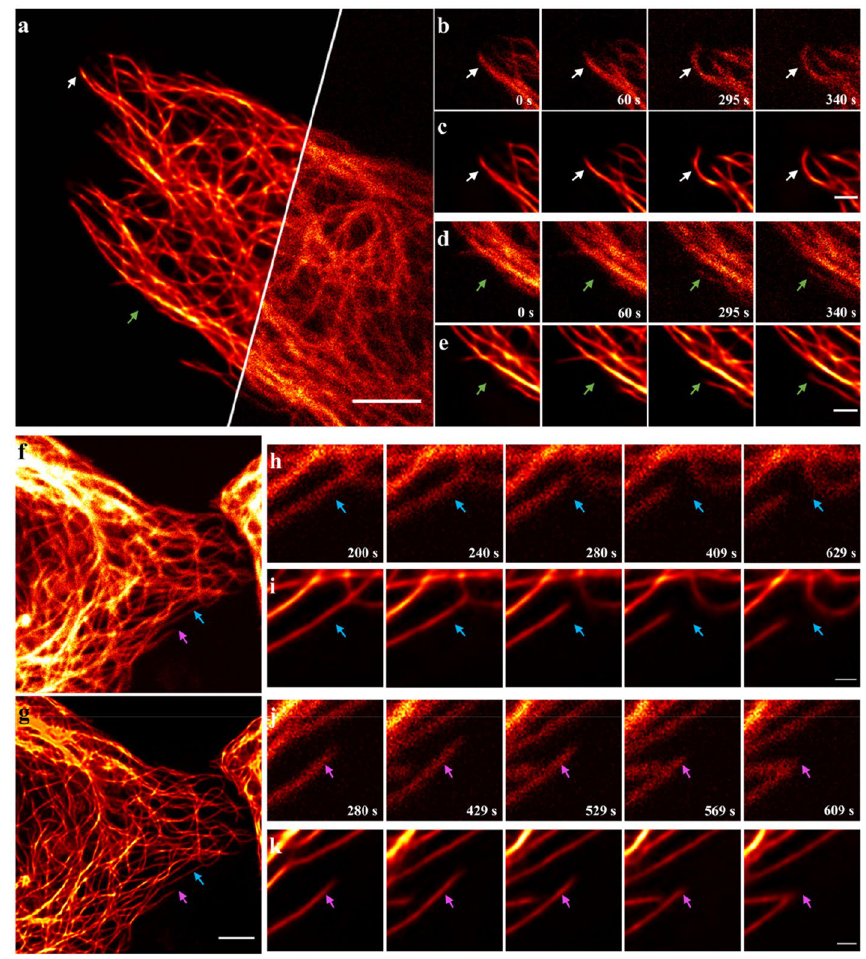
Fig. 8 Super-resolution imaging of live-cell microtubules using TCAN. ( a ) The super-resolved output image of live-cell microtubules. Bottom right: a fraction of the corresponding STED image (Leica TCS SP8 STED confocal microscope) used as comparison. Scale bar, 3 μm. ( b ), ( d ) Time-lapse STED images at four time points are shown at a magnified scale. ( c , e ) Time-lapse network output images at four time points are shown at a magnified scale. Scale bar, 1 μm. ( f ) A diffraction-limited confocal microscopy images (Nikon A1R MP microscope) used as input to the network. ( g ) The super-resolved output image of live-cell microtubules. Scale bar, 3 μm. ( h , j ) Time-lapse confocal images at five time points are shown at a magnified scale. ( i , k ) Time-lapse network output images at five time points are shown at a magnified scale. Scale bar, 0.5